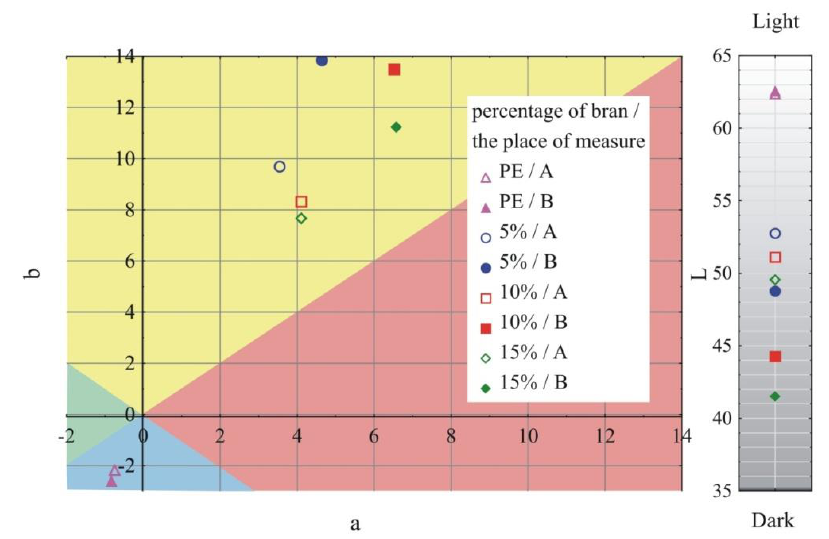
Figure 2. Variability of the color parameters L, a, b of injection mouldings depending on the mass fraction of bran and grain size < 0.4 mm at measuring points A and B (position of measuring points marked in Figure 1).